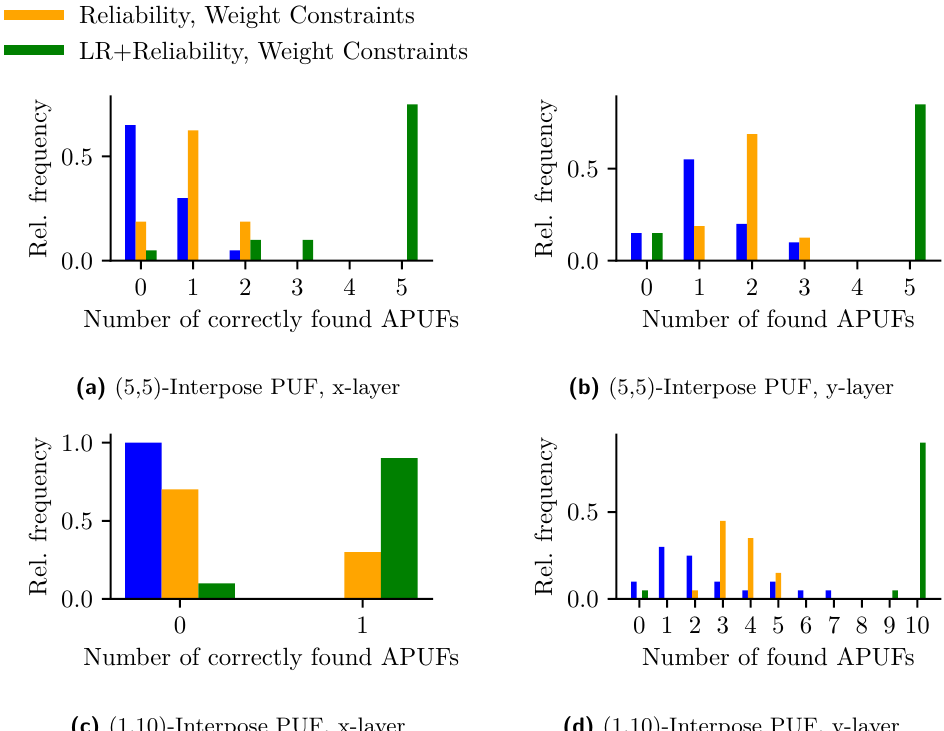
Figure 6: Result of different modeling attacks on iPUF constructs. In each experiment, 20 PUFs were attacked with eight trials in parallel in which the best trial was chosen for the attacks with constrains and 8( x + y ) trials for the unconstrained reliability attack which targets a single PUF model. An APUF is considered to be found when the Pearson correlation between PUF and model is larger than 0.99. The (5,5)-iPUF was learned with 200,000 unique challenges, (1,10) with 500,000. In both cases σ 2 was set to 0 . 1 and reliability information was collected over 10